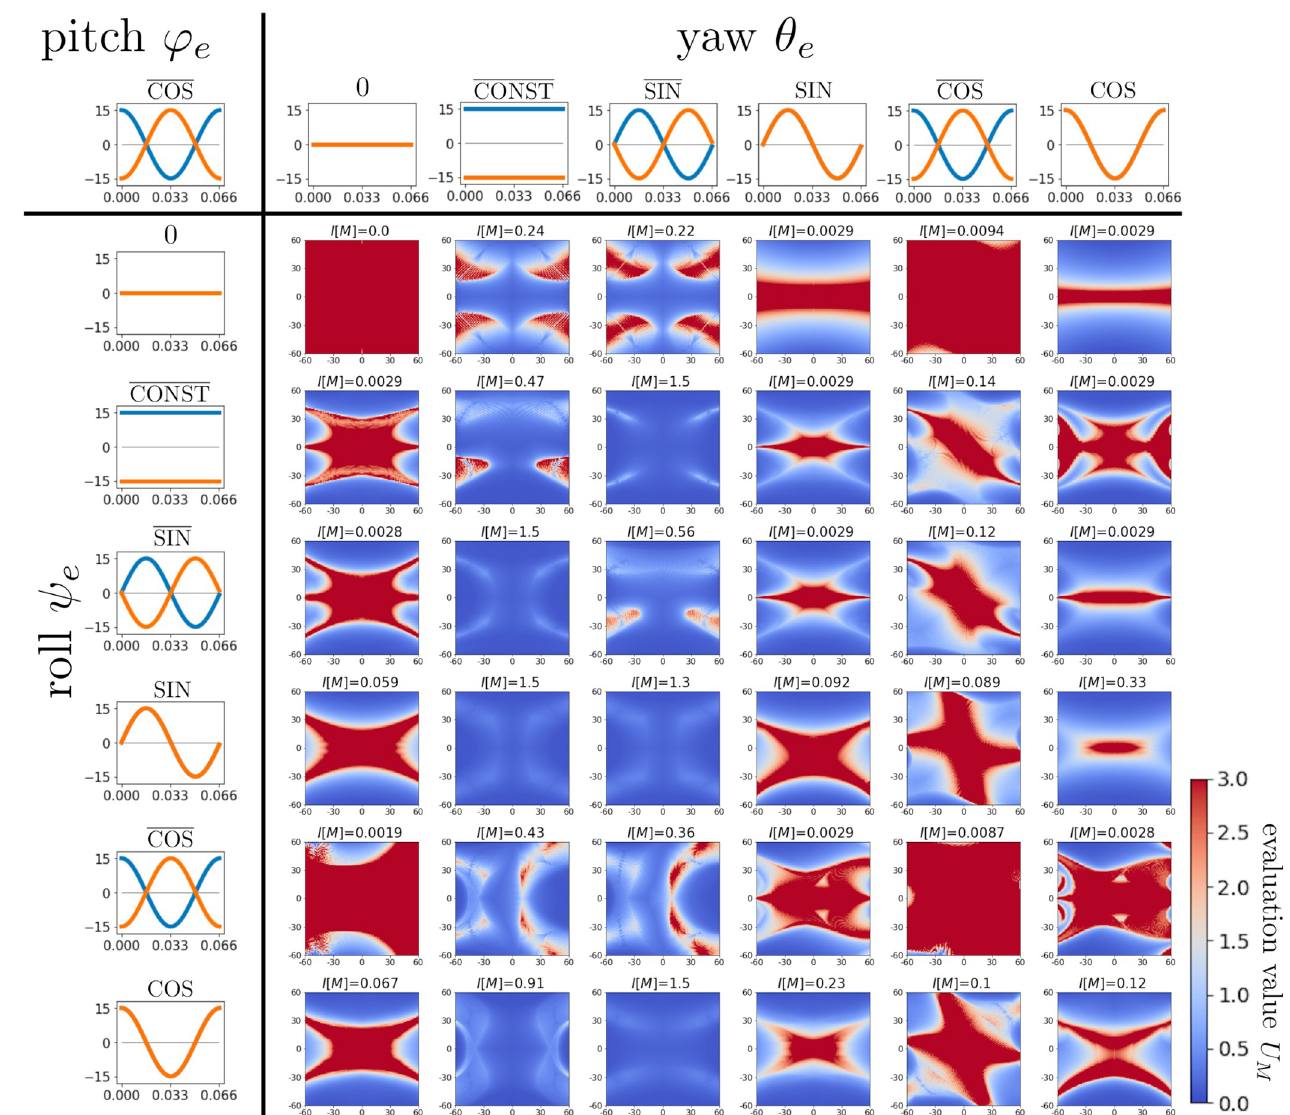
Fig 6. Colormaps of U M ( θ , φ ) and the degrees of injection for various ear motion patterns. The pitch angle functions φ l ; r actual bat behavior. Blue and orange lines indicate the angle functions of the left and right ears, respectively. The left and top array panels display the roll angle functions c l ; r and the yaw angle functions y l ; r , e e